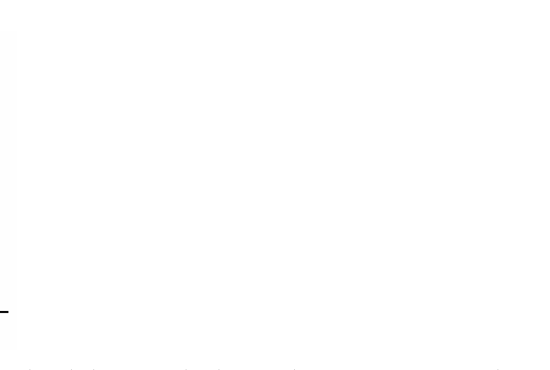
Figure 1. Comparison analysis of serum Se levels between body weight categories. Sample size: Normal weight = 34; Overweight = 19; Obesity = 43. Analysis by one way ANOVA.